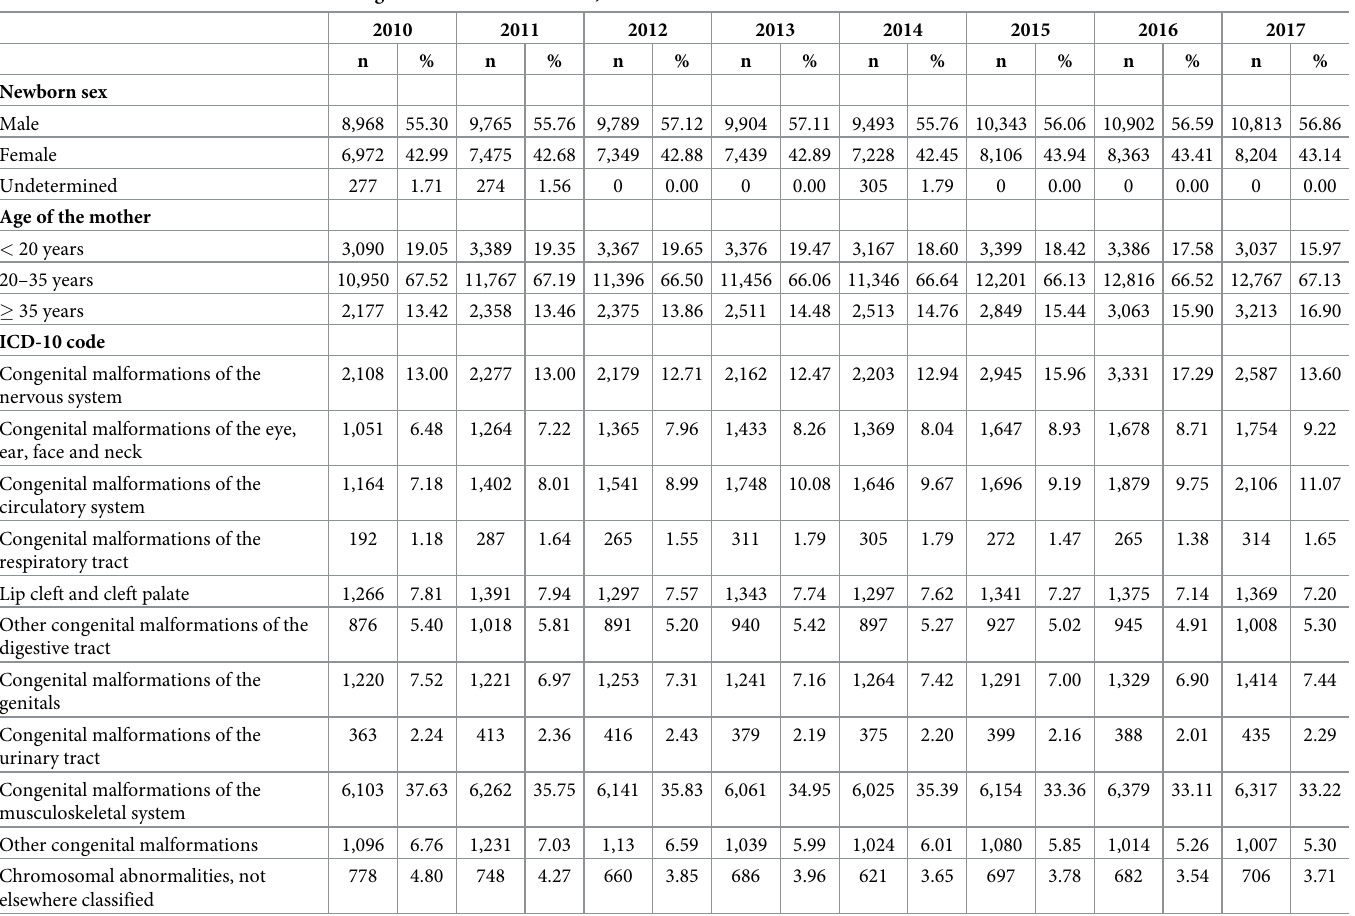
Table 1. Characteristics of live birth with congenital anomalies in Brazil,